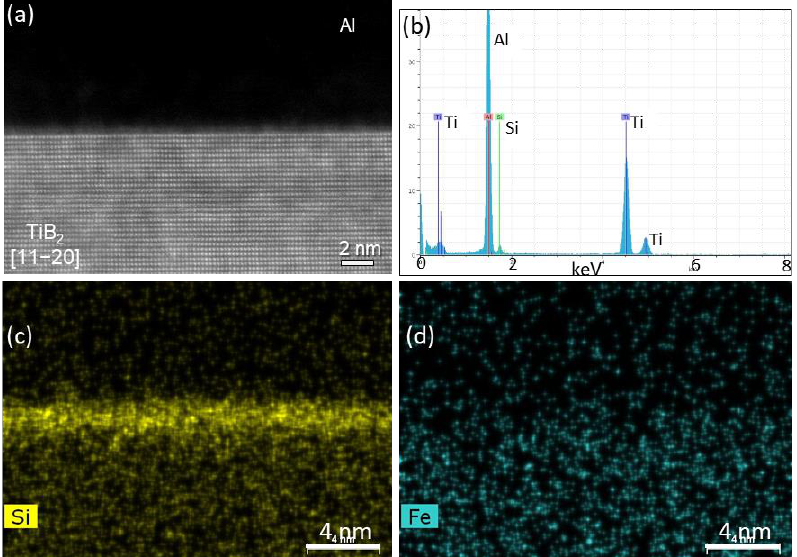
Figure 17. Si segregation at Al/TiB 2 interface data from [30]. ( a ) STEM-HAADF image of Al/TiB 2 interface for a TiB 2 particle from Al-8.4Si alloy containing 0.2% Al-5Ti-1B grain refiner; ( b ) Super-X EDS spectrum acquired from the interface; and ( c , d ) super-X EDS mapping of ( c ) Si and ( d ) Fe.